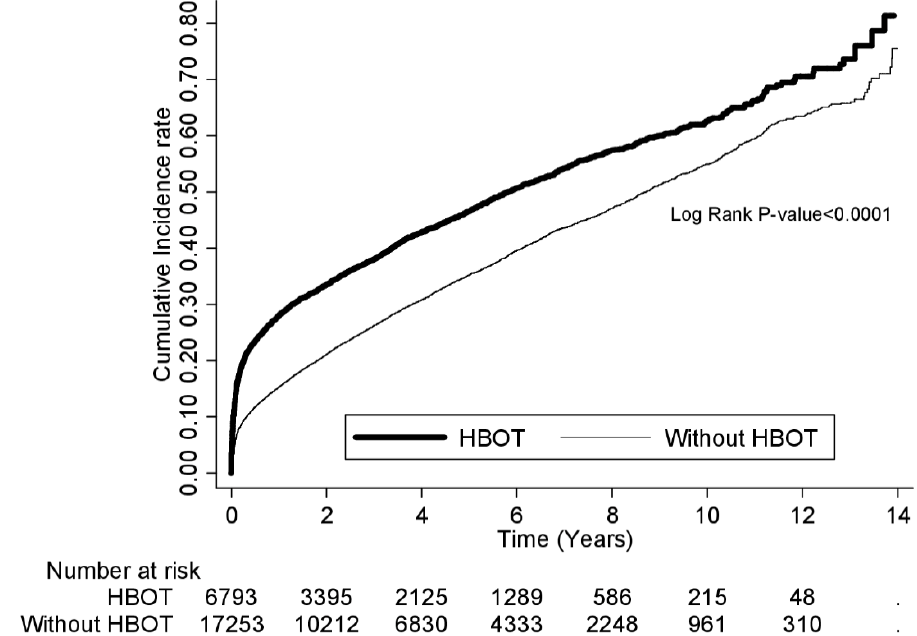
Figure 2. Follow-up risk for NS between COP patients with and without HBOT by Kaplan–Meier method with log-rank test.